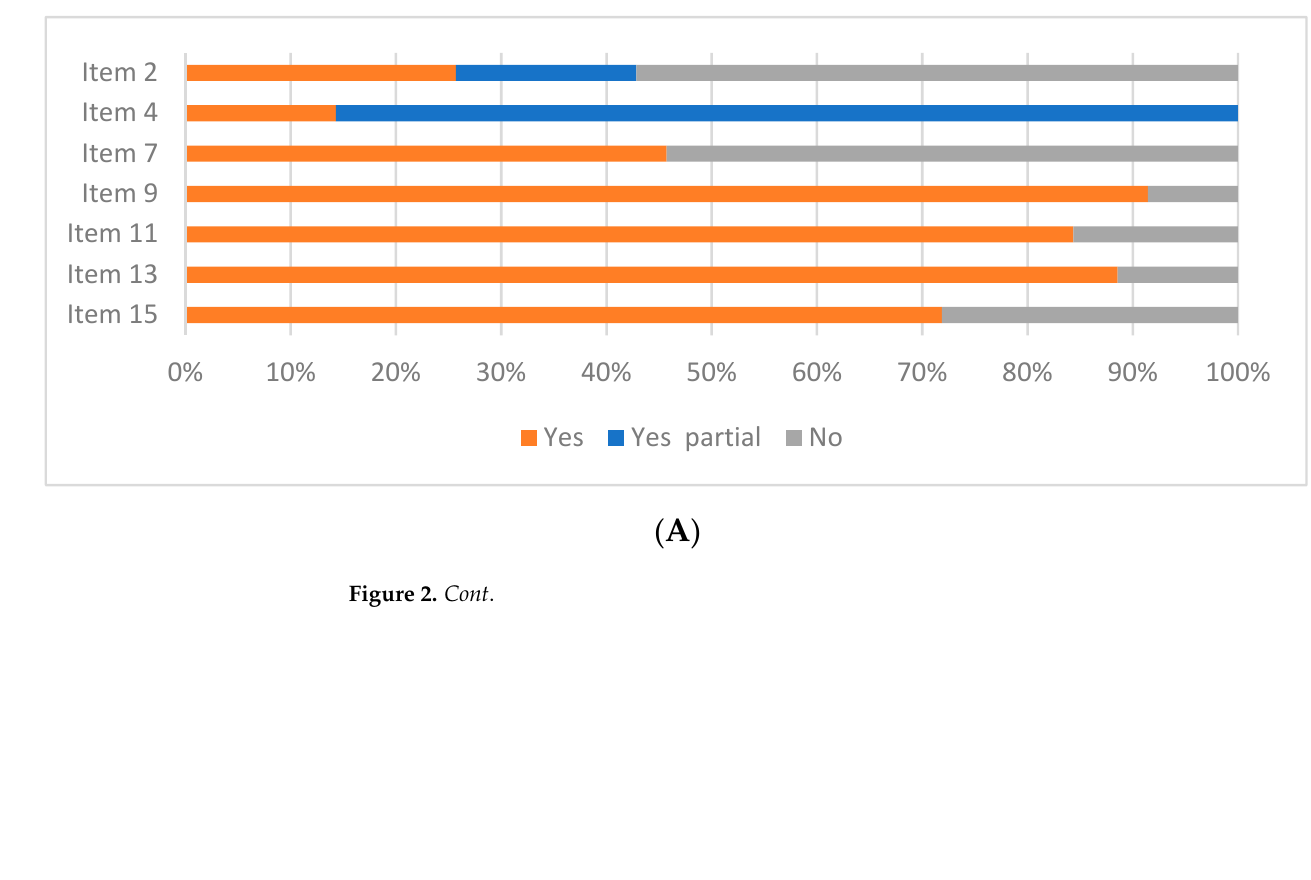
( B ) Figure 2. Accomplishment of systematic review with AMSTAR-2 items. ( A ) Critical items. ( B ) Non- critical items. Critical items: Item 2: Previous protocol review; Item 4: Adequate literature search; Item 7: Excluded studies justification; Item 9: Bias risk of individual studies included; Item 11: Ap- propriate meta-analysis methods; Item 13: Consideration of the bias risk in the interpretation of the review results; Item 15: Assessment of the presence and probable impact of publication bias. Non- critical items: Item 1: Research questions and inclusion criteria include PICO components; Item 3: Explaining decision about the study designs to include in the review; Item 5: Study selection per- formed in duplicate; Item 6: Data extraction performed in duplicate; Item 8: Describing included studies with sufficient detail; Item 10: Reporting the sources of funding for the studies included in the review; Item 12: Assessing the potential impact of bias risk on results; Item 14: Satisfactory ex- planation and discussing any observed heterogeneity in the review results; and Item 16: Potential sources of conflict including any funding received. 3.3. Overlapping between Reviews Analysis of the overlapping was performed by groups of systematic reviews deter- mined by: (a) The year of publication, differencing between systematic reviews published before 2015 and from 2015. (b) The type of the evaluated interventions: “physical activity”, “diet” or “mixed interventions”. (c) Characteristics of the study population according to risk pregnancy: “pregnant women at high risk” and “pregnant women in general”.